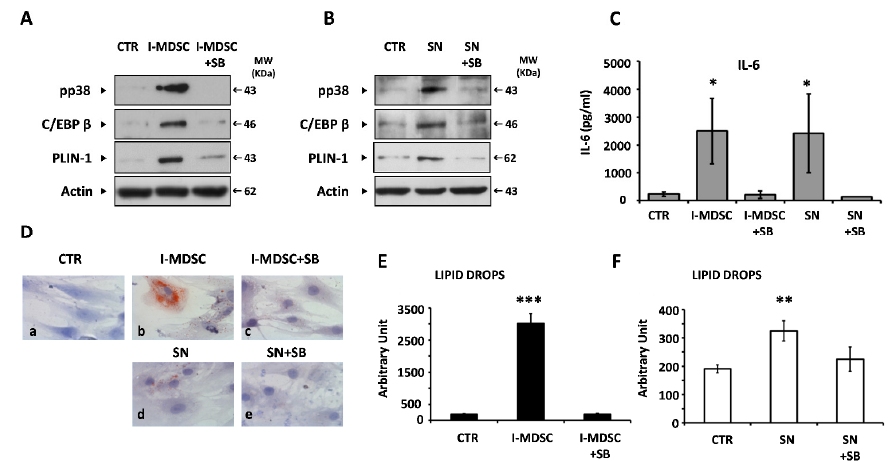
Figure 4. Myeloid cells and soluble factors secreted during co-culture induce IL-6 gene expression and adipogenesis in BM-MSCs. ( A , B ). Representative immunoblotting analysis of the phosphorylation of p38 MAPK, the expression of the 47 KDa isoform of C/EBP β , and PLIN-1 accumulation in BM-MSCs co-cultured with I-MDSCs ( A ) or treated with co-culture supernatants ( B ) in the presence or absence of SB. β -Actin ensured equal loading in the lanes. Arrows indicate relevant bands in all panels. ( C ). IL-6 production of BM-MSCs cultured with the indicated stimuli. Values are the mean ± SD of results obtained in several independent experiments. ( D ). Representative red oil staining of BM-MSCs cultured in standard medium (panel a ), co-cultured with I-MDSCs in the absence (panel b ) or presence (panel c ) of the p38 MAPK inhibitor SB202190 (SB), or treated with BM-MSC/I-MDSC co-culture supernatants in the absence (panel d ) or presence (panel e ) of SB. ( E , F) . Diagrams of pixel quantification of lipid drops content relative to images in ( D ), generated with ImageJ (http://imagej.nih.gov/ij/, 1997–2011, accessed on 21 December 2021), in BM-MSC cultures. Values are the mean values ± SD of area pixels obtained in at least three independent experiments. * p < 0.05, ** p < 0.01, *** p < 0.001.